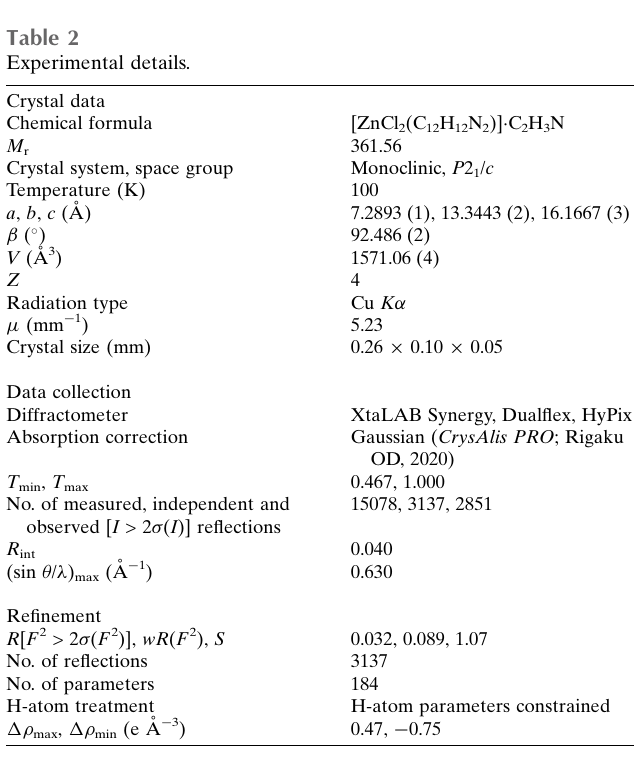
Table 2 Experimental details.